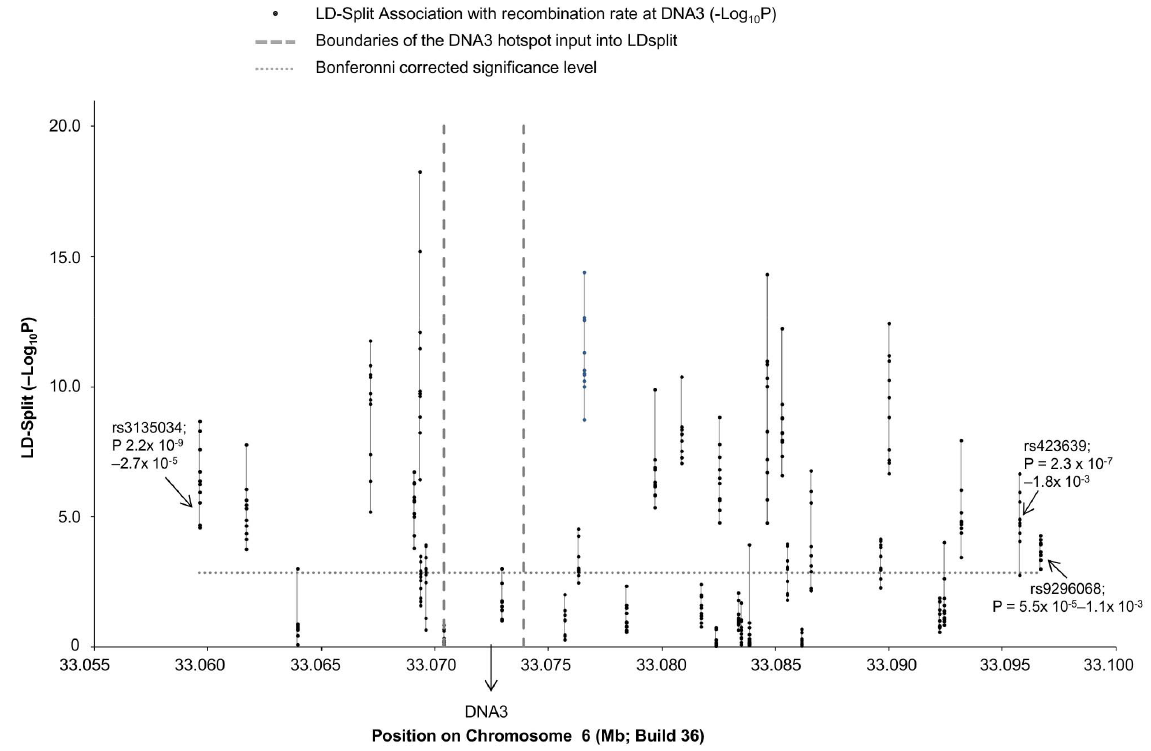
Figure 3. Results of LDsplit analysis for association of SNPs flanking DNA3 with hotspot intensity. For each SNP included in the HAPMAP-CEU phased haplotypes (Table S3), ten estimates of -Log10P values for association with hotspot intensity are plotted (black spots joined by lines). P values of SNPs identified in association studies of childhood ALL are indicated. The boundaries of the DNA3 hotspot used for the analysis are indicated by vertical dashed lines and the corrected P value cut-off is shown by a horizontal dotted line.